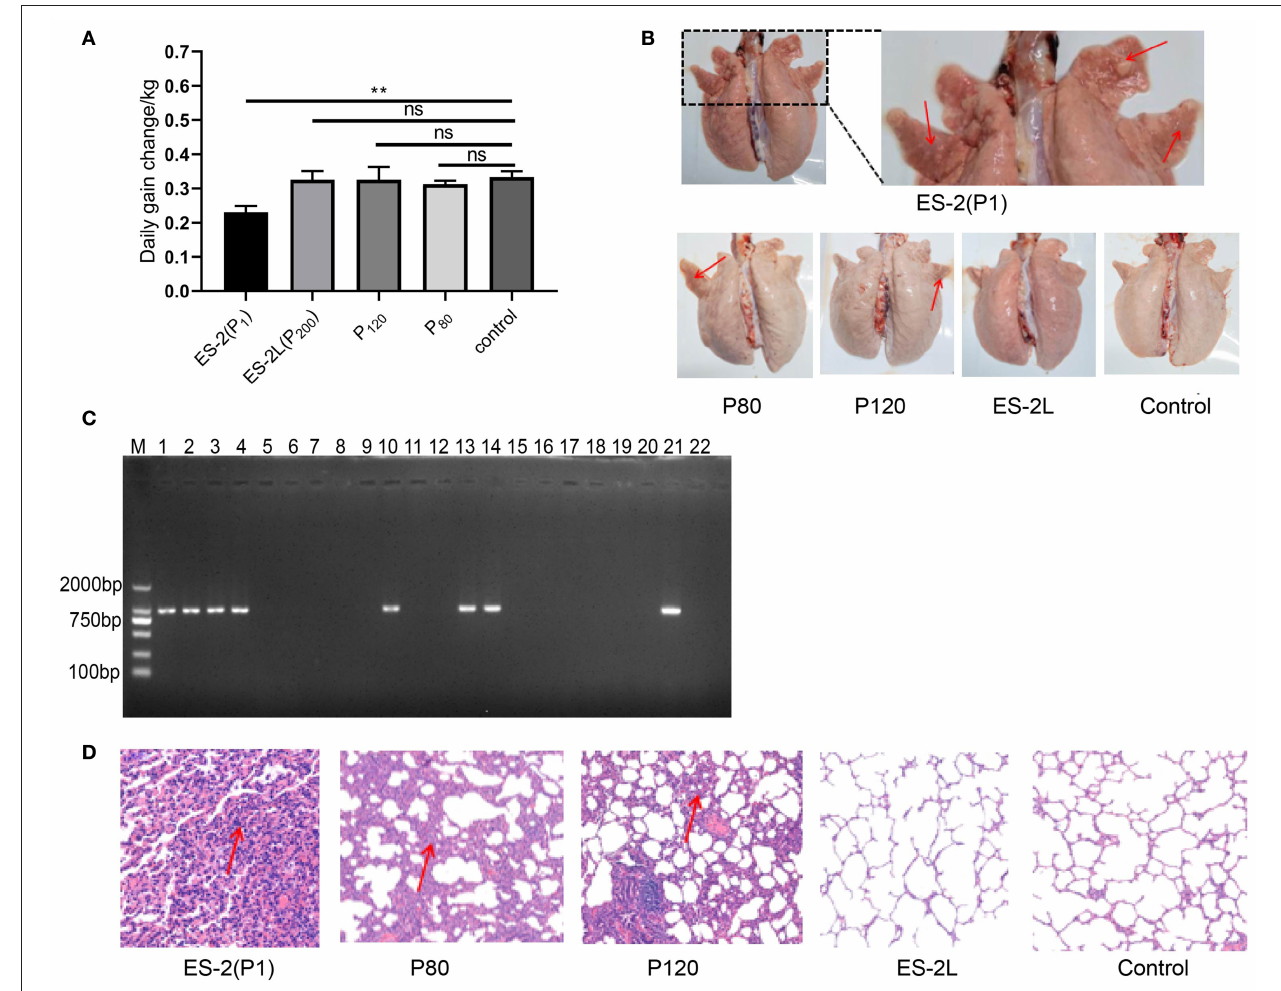
FIGURE 2 | (A) Change of average daily weight gain in each group; data are presented as the means ± SD ( n = 4); ** P < 0.01, Student’s t -test. (B) Observation of lung tissue macroscopic lesions in each group; all pigs in the P1 group had typical “red consolidations” lesions of lung tissue (indicated by the red arrow). None of the pigs in the ES-2L group showed typical lesions. (C) Detection of P36 gene (948 bp) by PCR assay for pig’s lungs of each group: M, DNA marker 2,000; lanes 1, 2, 3, and 4 correspond to P36 gene on ES-2 group; lanes 5, 6, 7, and 8 correspond to P36 gene on ES-2L group; lanes 9, 10, 11, and 12 correspond to P36 gene on P120 group; lanes 13, 14, 15, and 16 correspond to P36 gene on P80 group; lanes 17, 18, 19, and 20 correspond to P36 gene on control group; lane 21, positive control; lane 22, negative control. (D) Examination of lung tissue hematoxylin and eosin staining by microscopy at 100-fold magnification; the red arrow indicates that there were severe mononuclear cell and lymphocyte infiltration and alveolar consolidation in lung